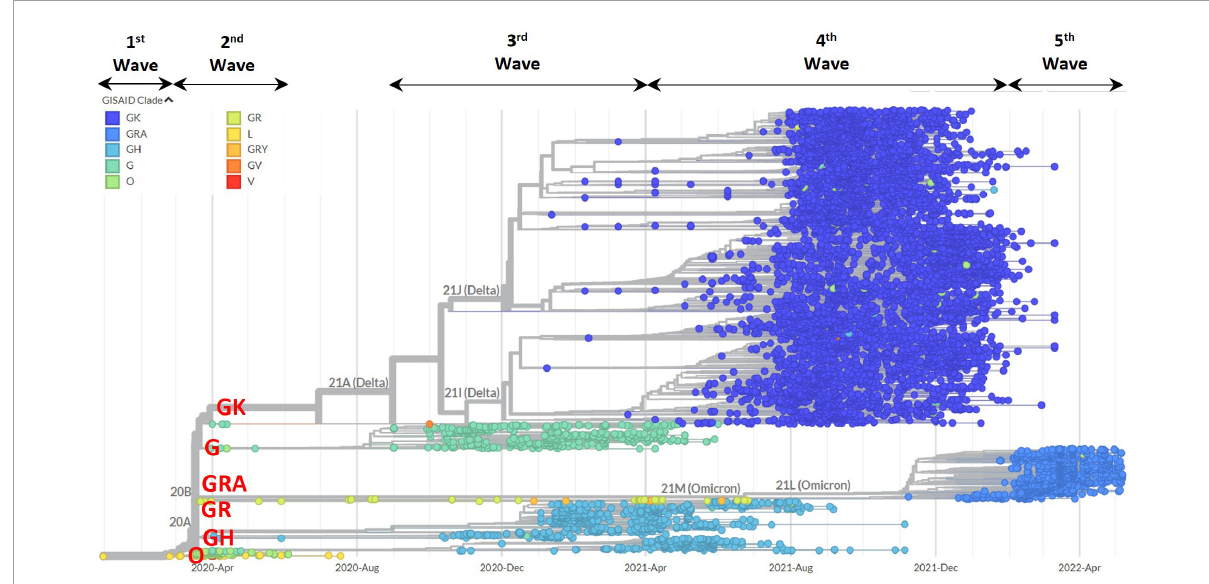
FIGURE5 Phylogenetic tree analysis of 8,717 genomic sequences in Malaysia based on clade distributions and collection date. The clades are represented by different color codes. The major clades in Malaysia (GRA, GK, GH, G, O, and GR) are highlighted in